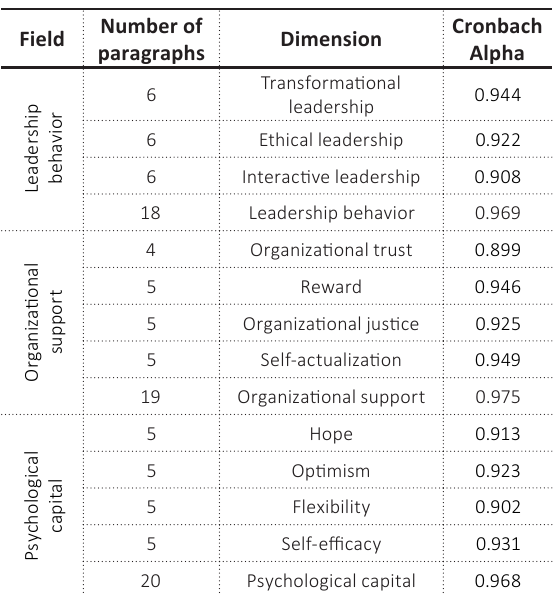
Table 1. Cronbach Alpha method for study tool areas